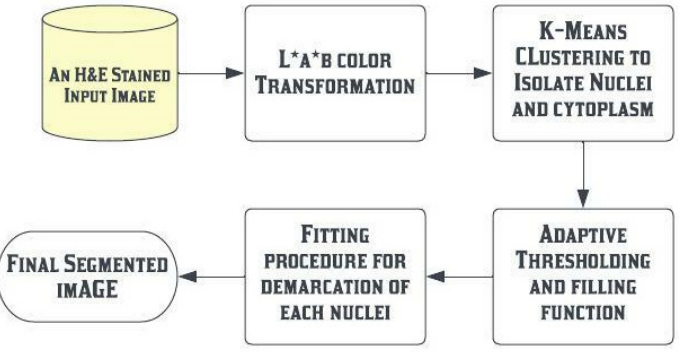
Figure 3. Process flow diagram of proposed segmentation approaches.